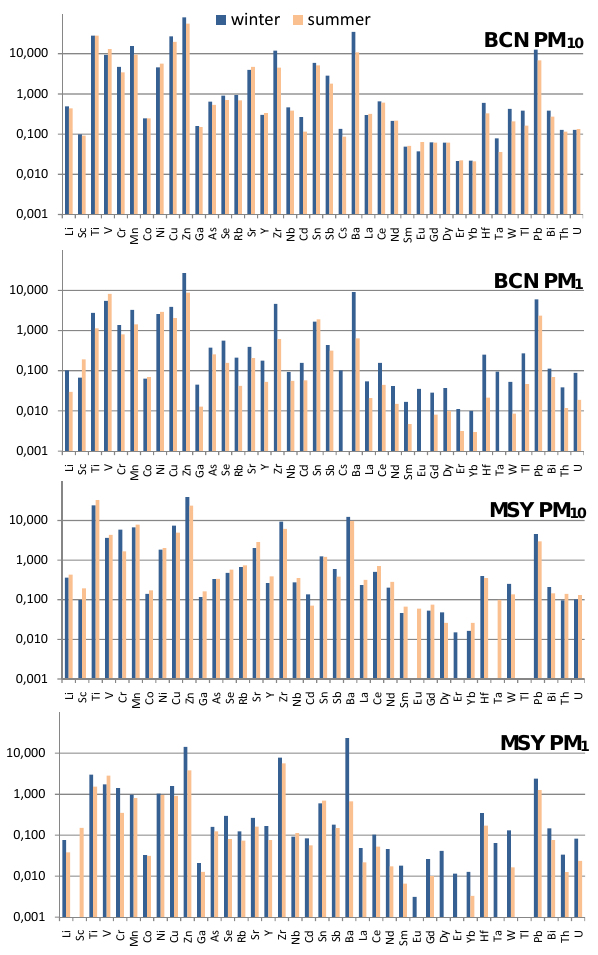
Fig. 4. Average PM 10 and PM 1 trace metal concentrations at the BCN and MSY sites for both summer and winter campaigns (ng m − 3 ). In BCN PM 10 metal concentrations were clearly higher dur- ing winter, while differences between campaigns were smaller in MSY (with PM 10 showing lower levels of most metals during win- ter). Whereas in BCN same pattern was observed in the PM 1 size fraction, the distribution of metals in this fraction at MSY was how- ever quite different, with the winter PM being generally much more metalliferous.